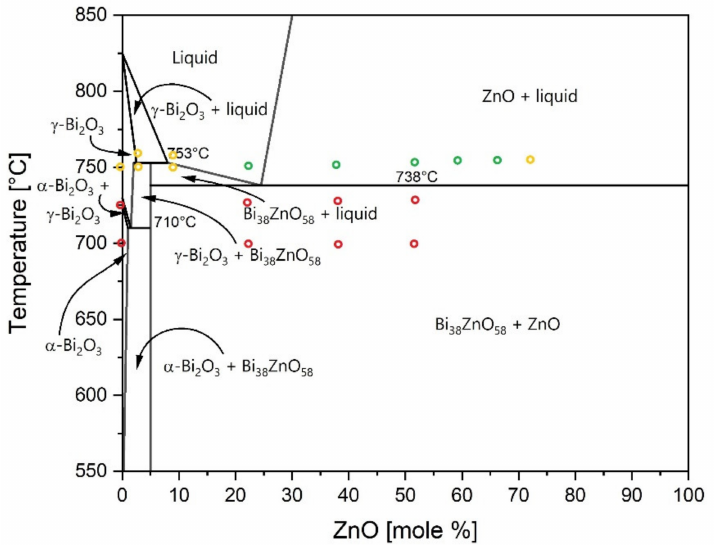
Figure 8. Phase diagram of Bi 2 O 3 -ZnO system; the circles in the phase diagram indicate the tested interlayer compositions and joining temperatures. Red circles indicate no bonding, yellow circles indicate weak bonding and green circles indicate strong bonding (Reprinted/adapted with permission from Ref. [36]. 2004, Springer